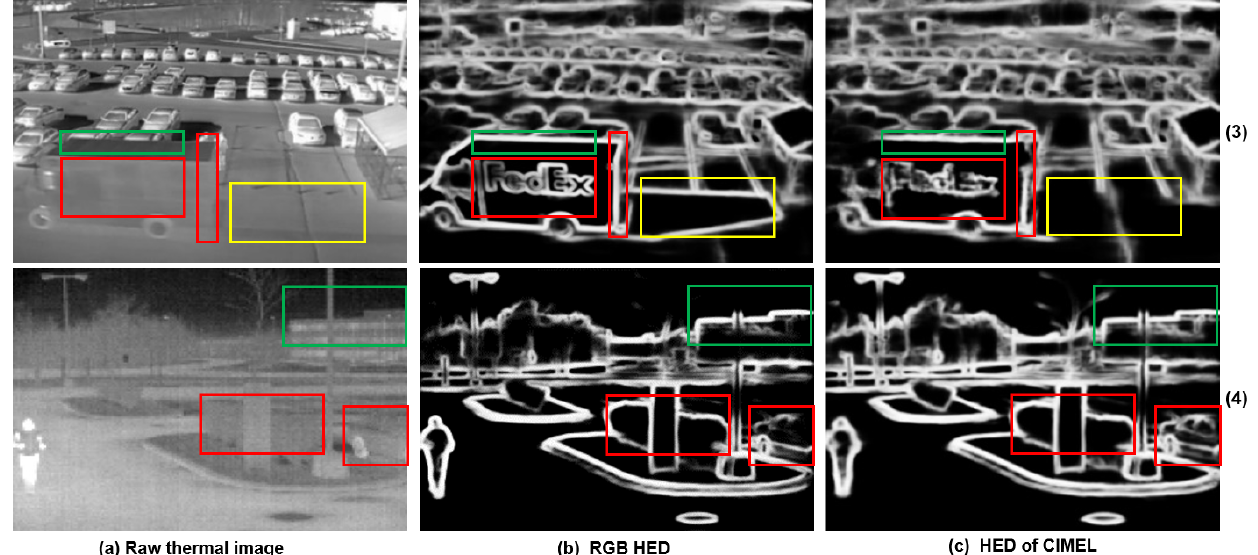
Figure 6. Three types of edges from the HED algorithm: Edges invisible in the IR spectrum but visible in the corresponding visual image (yellow rectangle); Edges weak in the IR spectrum but strong in the corresponding visual image (red rectangle); Edges which are strong in both IR and visual images (green rectangle).